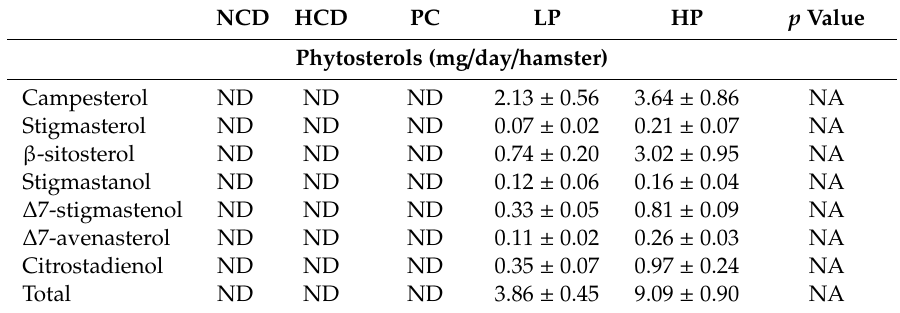
Table 3. Daily fecal excretion of phytosterols at week 6 in hamsters fed one of the five diets: NCD, no cholesterol diet; HCD, high cholesterol diet containing 0.1% cholesterol; PC, high cholesterol diet containing 0.5% cholestyramine; LP, high cholesterol diet containing a low dose (0.1%) soybean germ phytosterols (SGP); HP, high cholesterol diet containing a high dose (0.2%) soybean germ phytosterols